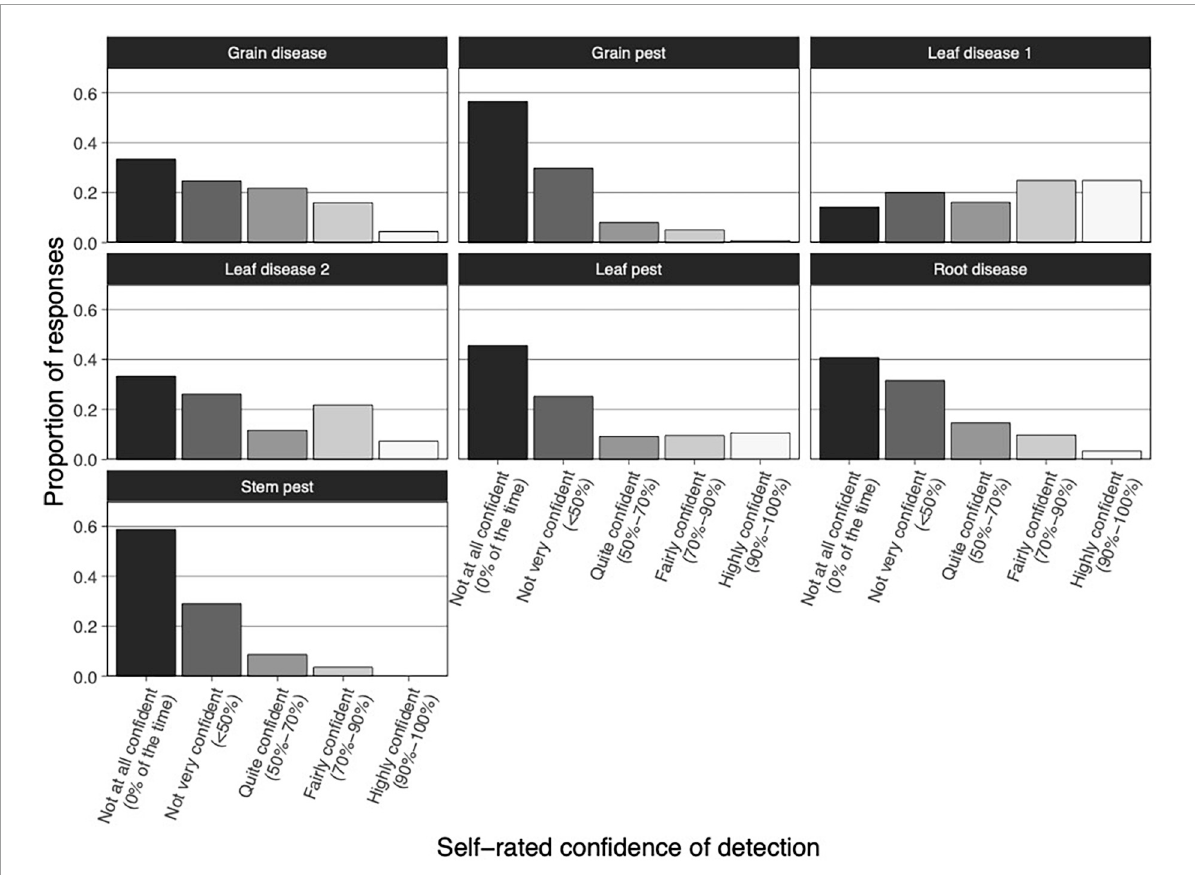
FIGURE4 Crop Safe agronomists’ self-rated confidence of detection of exotic pests and diseases at visual inspection. Pests and diseases are divided into seven groups. Vertical bars represent the proportion of responses. Bar gray scaling indicates differences in self-rated confidence of detection, ranging from “not at all confident” to “highly